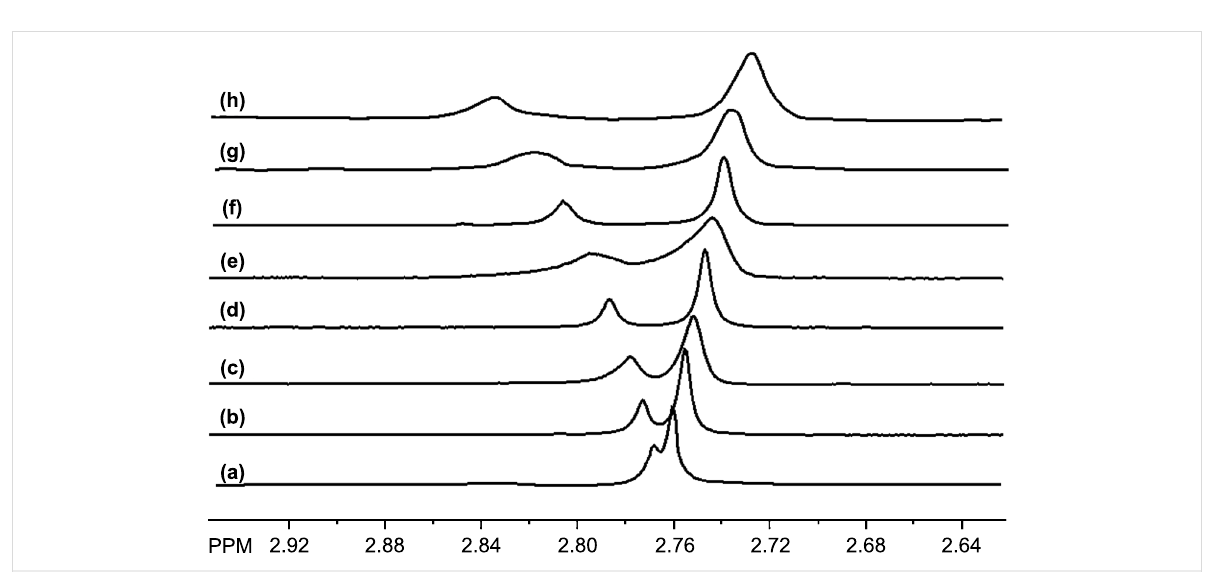
Figure 5: The N -methyl resonance of 7 (10 mM, enriched in (1S,2R)-enantiomer) with P- β -CD-L DS (20 mM) and concentrations of ytterbium(III) nitrate of (a) 0 mM, (b) 2 mM, (c) 4 mM, (d) 6 mM, (e) 8 mM, (f) 10 mM, (g) 12 mM and (h) 16